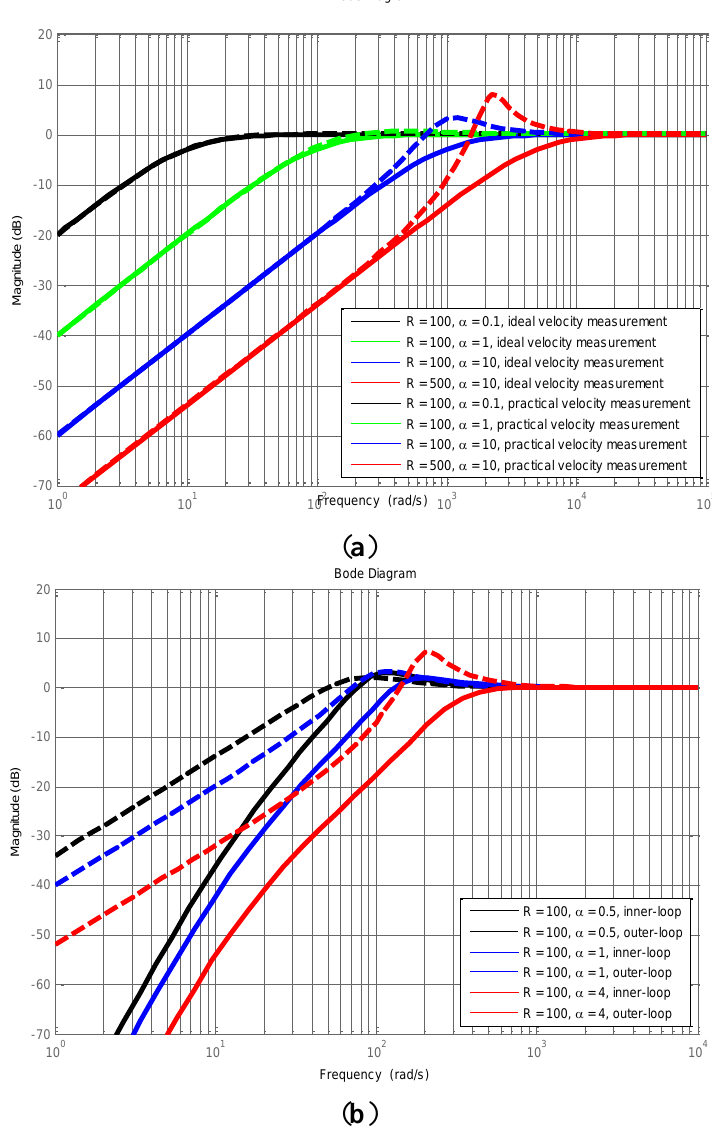
Figure 4. Bode plots of the sensitivity functions of the inner and outer loops for different values of α and R . ( a ) Sensitivity functions’ frequency responses of inner-loop; ( b ) Sensitivity functions’ frequency responses of inner and outer